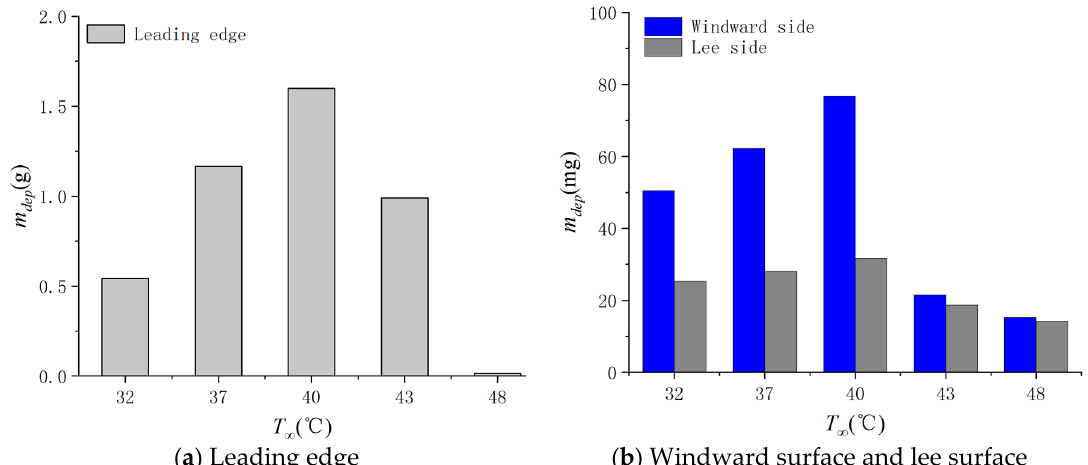
Figure 17. Deposition mass with different mainstream temperature.